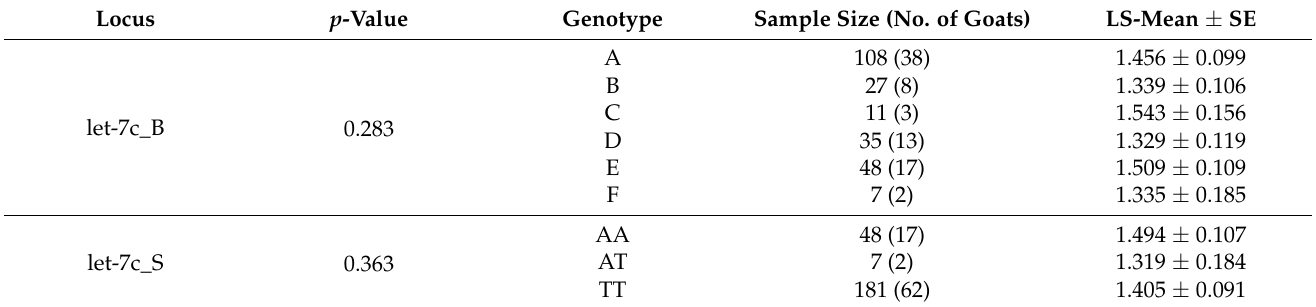
Table 2. Least square means and standard errors for litter size of different genotypes of detected SNPs in Markhoz